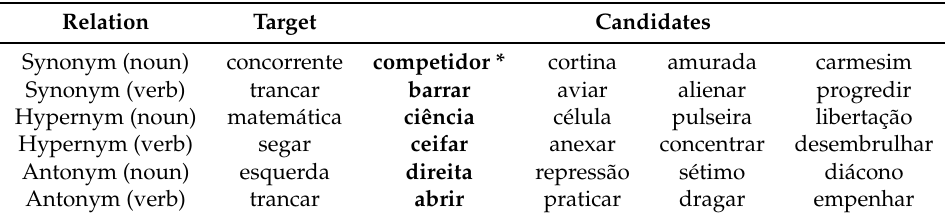
Table 10. First entries of each file of the B 2 SG